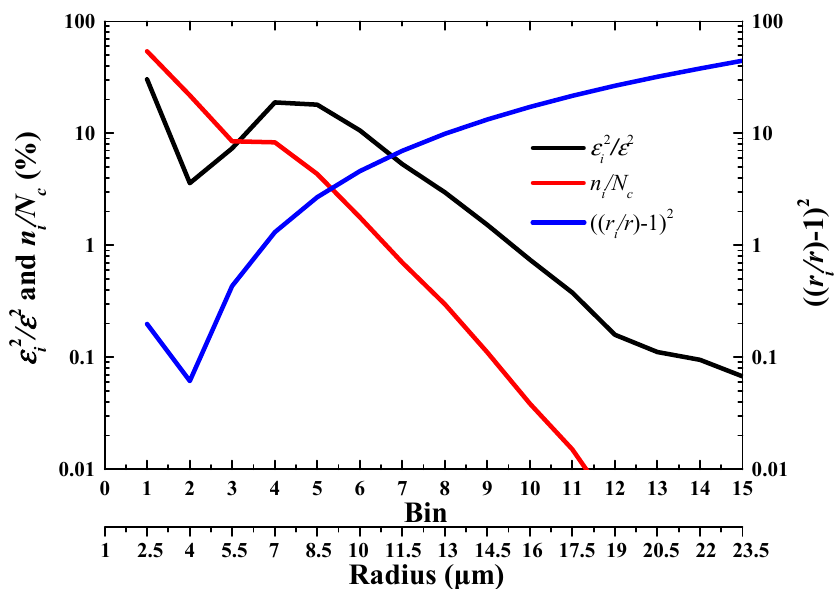
Figure 7. The relationship between ε 2 / ε 2 and bins of CDSD as well as that between n i / N c and bins, and i (cid:0) r − 1 (cid:1) 2 and bins, where the ε , N c , and r represent the dispersion, number concentration, and mean radius of CDSD.